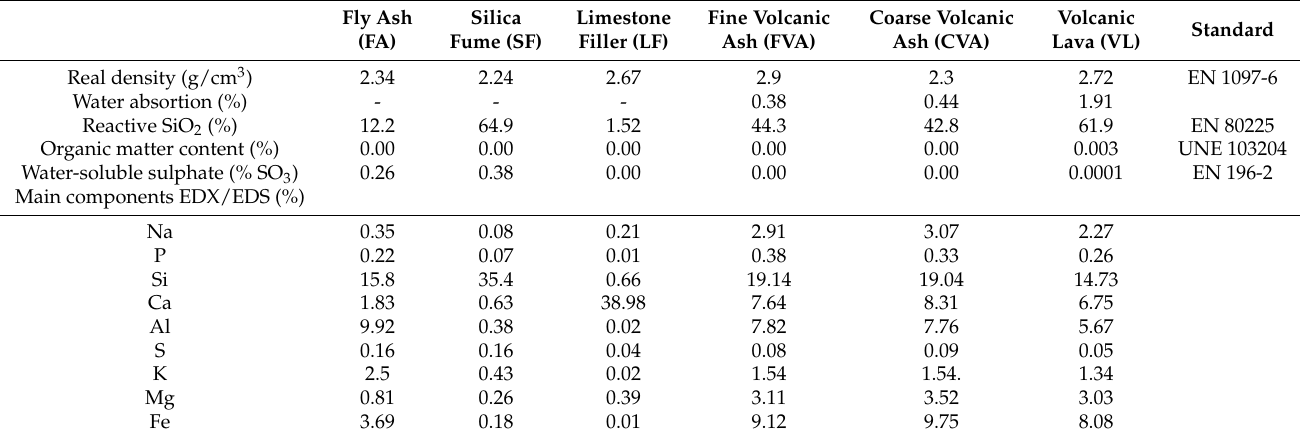
Table 2. Physicochemical properties of the raw pozzolans.